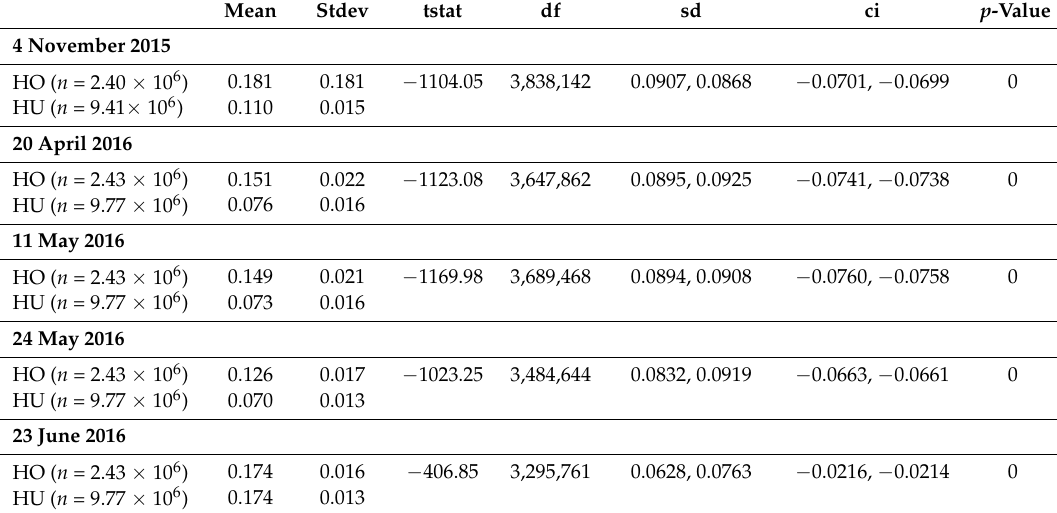
Table 3. Mean, standard deviation and t -test statistics for paired t -test comparison results of NDWI 1640 spectral index (near-surface water content) for hollows (HO) and hummocks (HU) for five dates at the MB bog.